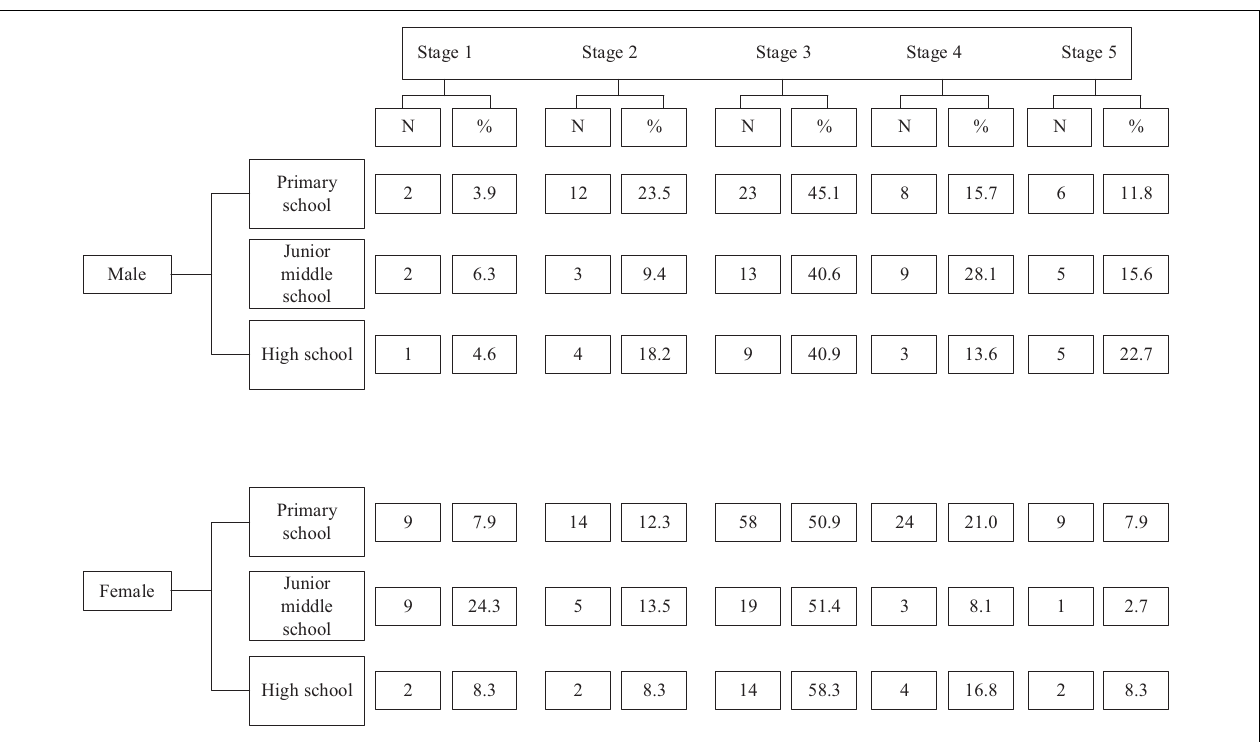
FIGURE 7 | Distribution of the students of different grades at different stages of